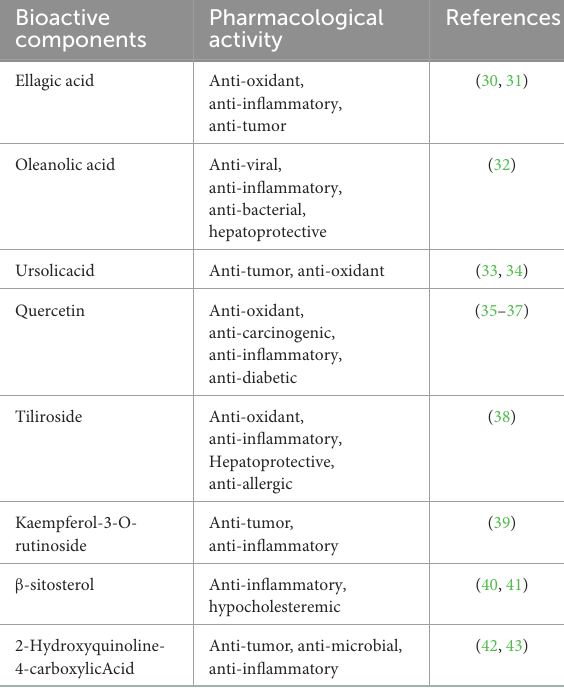
TABLE 2 The pharmacological effects of the main bioactive components of R.chingii Hu. Bioactive